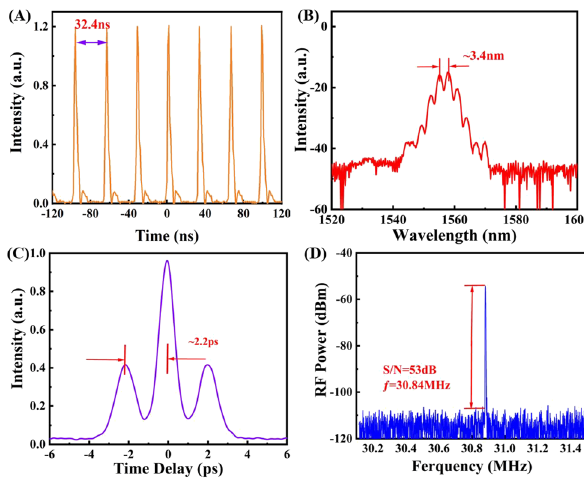
Figure 6: Output performance of soliton molecules. (A) Oscilloscope trace. (B) Optical spectrum. (C) Autocorrelation trace. (D) RF